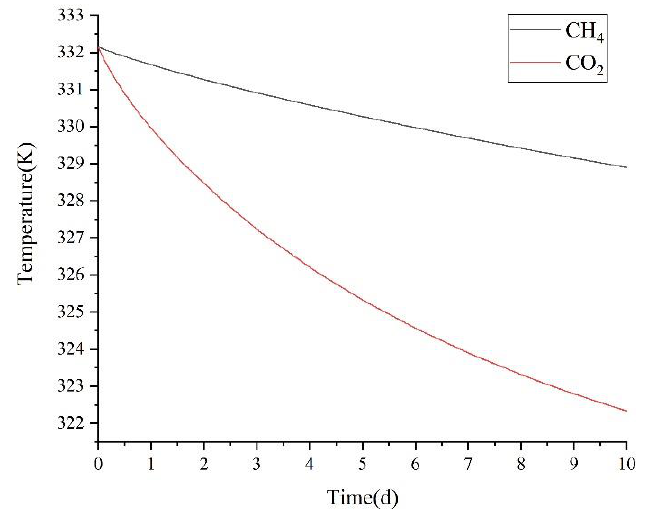
Figure 14. Average temperature comparison at the centerline of the salt cavity at the end of withdrawal.